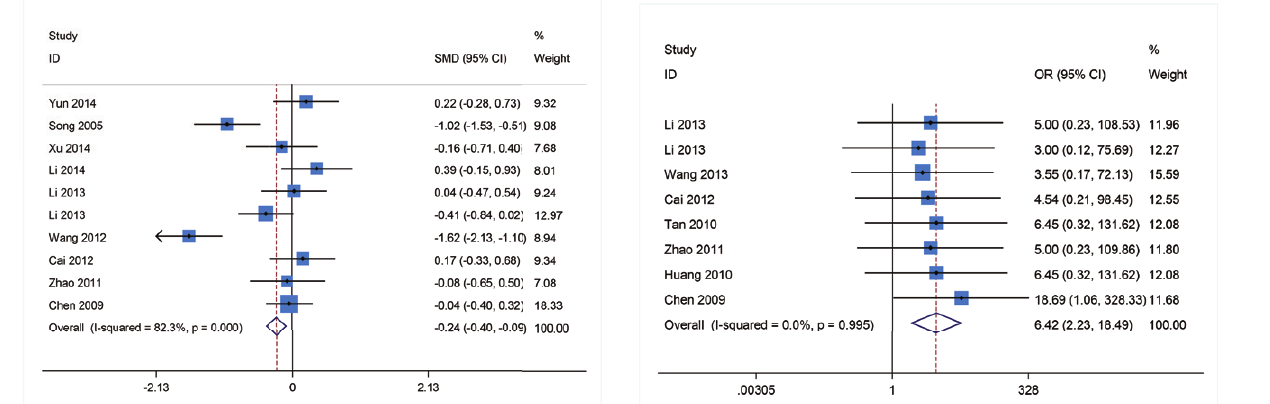
Figure 5: Forest plot of serum creatinine for tripterygium glycosides in treatment of stage IV diabetic nephropathy. (The squares and horizontal lines demonstrate the study-specific OR and 95% CI. The area of the squares reflects the study specific weight (inverse of the variance). The diamond represents the pooled OR and 95% CI).